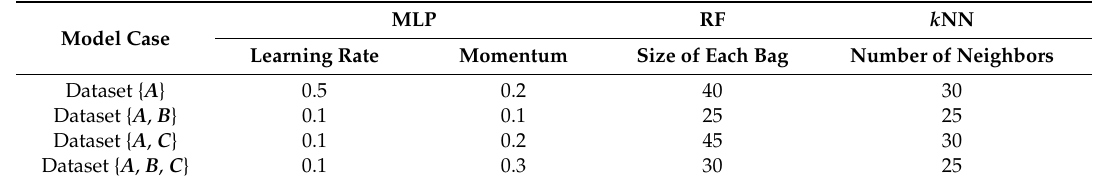
Table 2. Optimal parameters for all model